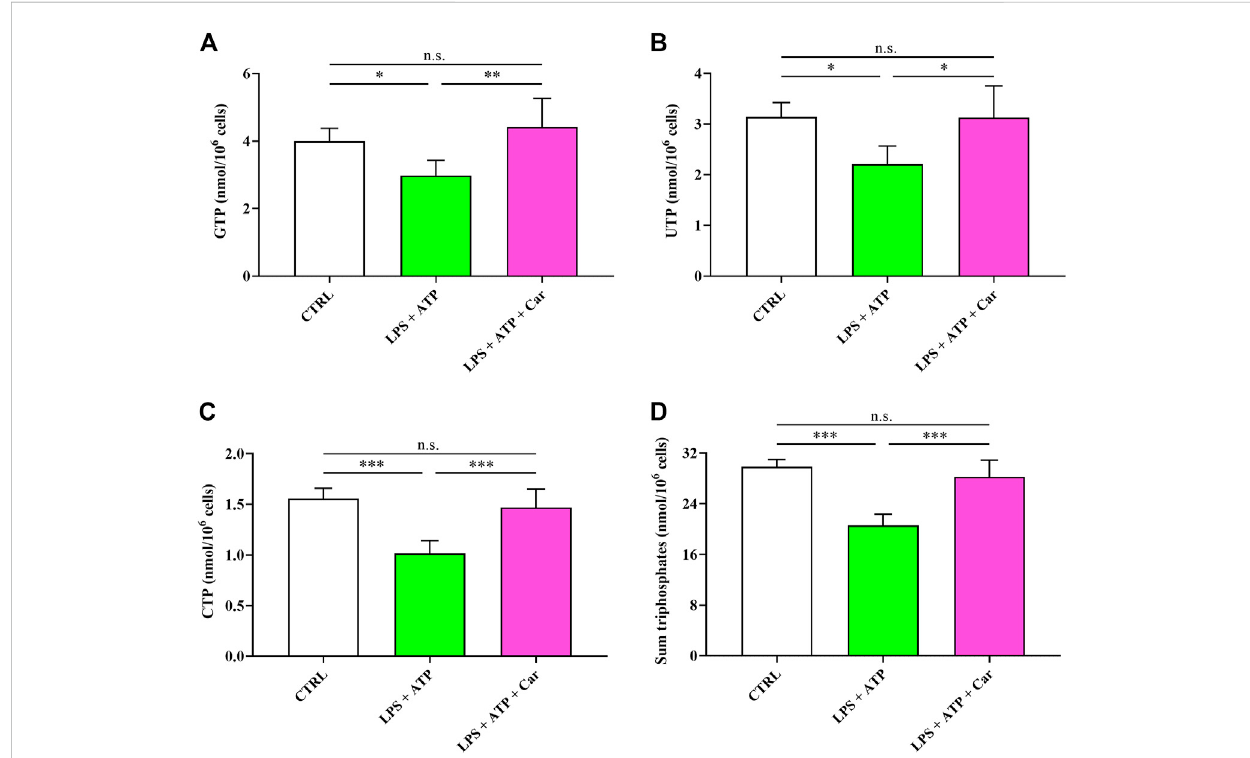
FIGURE 4 Values of (A) GTP, (B) UTP, (C) CTP, and (D) sum of triphosphates (ATP + GTP + UTP + CTP) determined in resting HMC3 cells and HMC3 cells exposedto LPS(100 ng/mL, 24 h)+ ATP (5 mM,30 min),intheabsence orpresenceofcarnosine(Car)(10 mM,1 hpre-treatment).Data represent mean of four different samples. Standard deviations are represented by vertical bars. *Signi fi cantly different, p < 0.05; **Signi fi cantly different, p < 0.01; ***Signi fi cantly different, p <